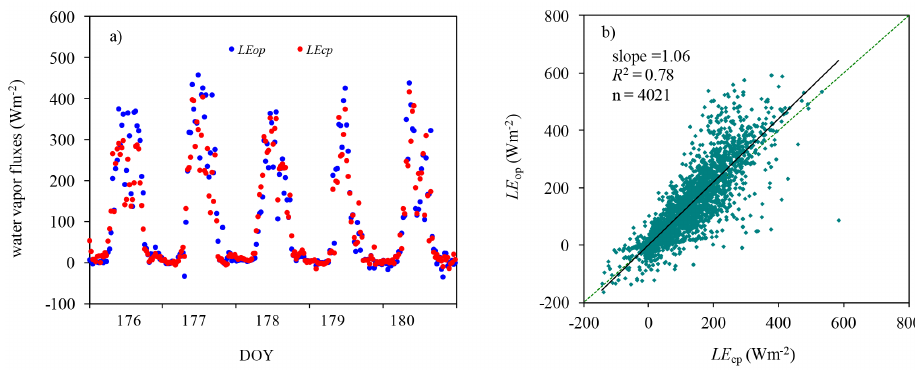
Figure 5. Comparison of diurnal course of water vapor fluxes derived from open- and closed path system at the Changbai Mountains forest site (a) , and open-path system measured water vapor fluxes ( LE op ) vs. closed-path ( LE cp ) water vapor fluxes in the whole growing season of 2003 (b) .